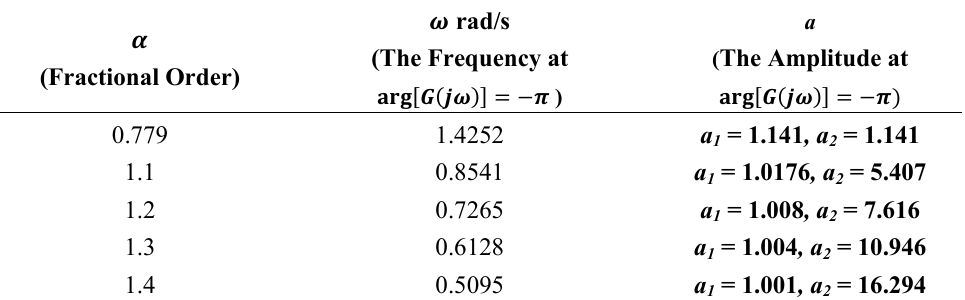
Figure 25. Nyquist plots for different values of with dead